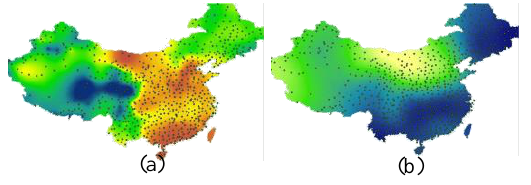
Figure 3. 2009 distribution map of mean annual temperature and mean relative humidity (a) mean annual temperature; (b) mean relative